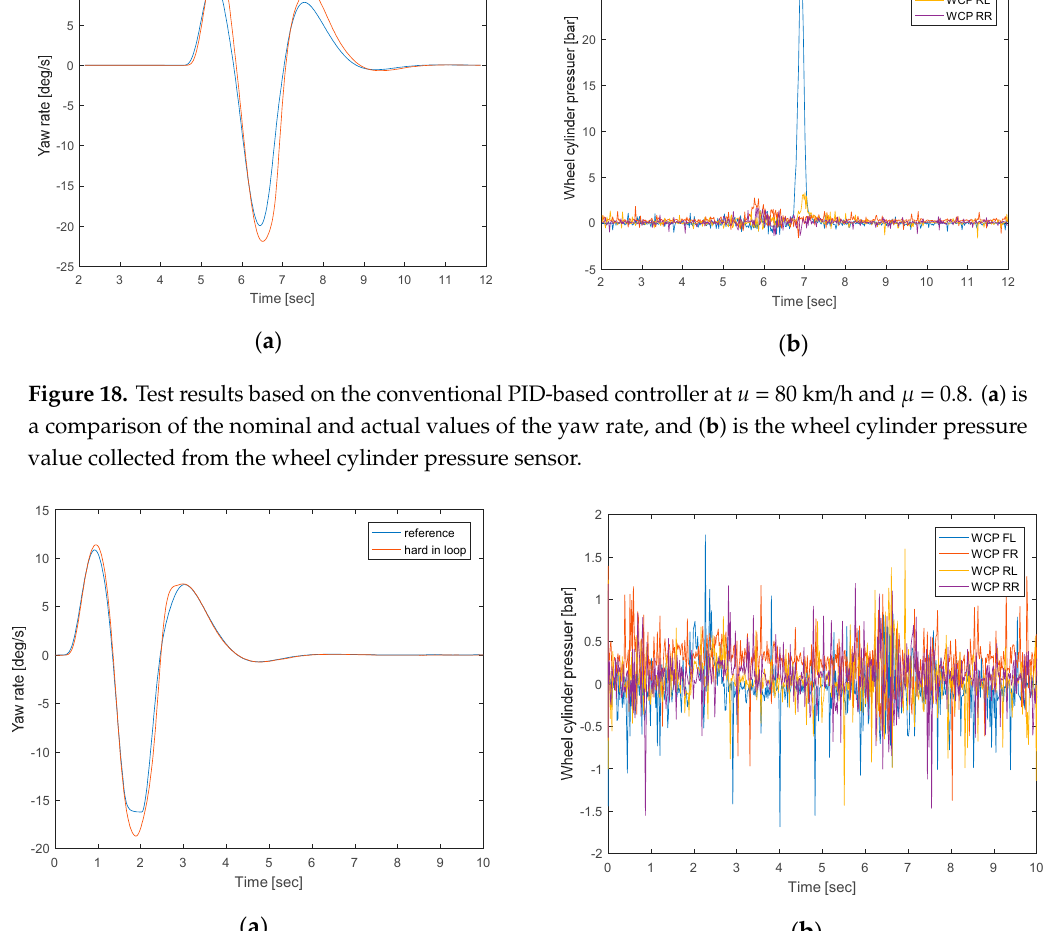
Figure 19. Test results based on the tire force observation controller at 𝑢 = 100 km/h and 𝜇 = 0.8. ( a ) is a comparison of the nominal and actual values of the yaw rate, and ( b ) is the wheel cylinder pressure value collected from the wheel cylinder pressure sensor.